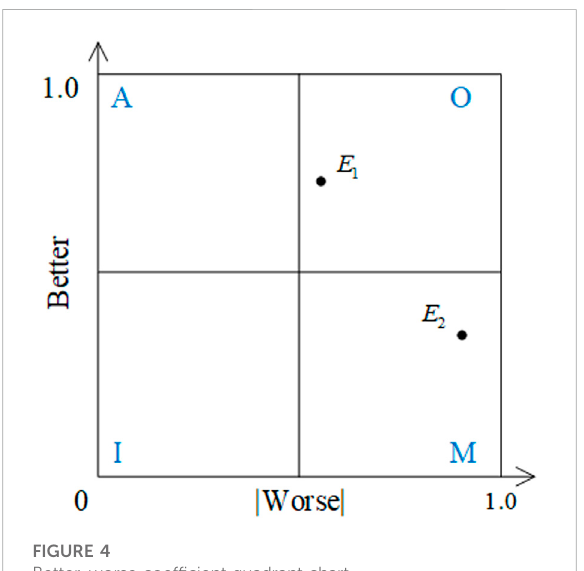
FIGURE 4 Better-worse coef fi cient quadrant